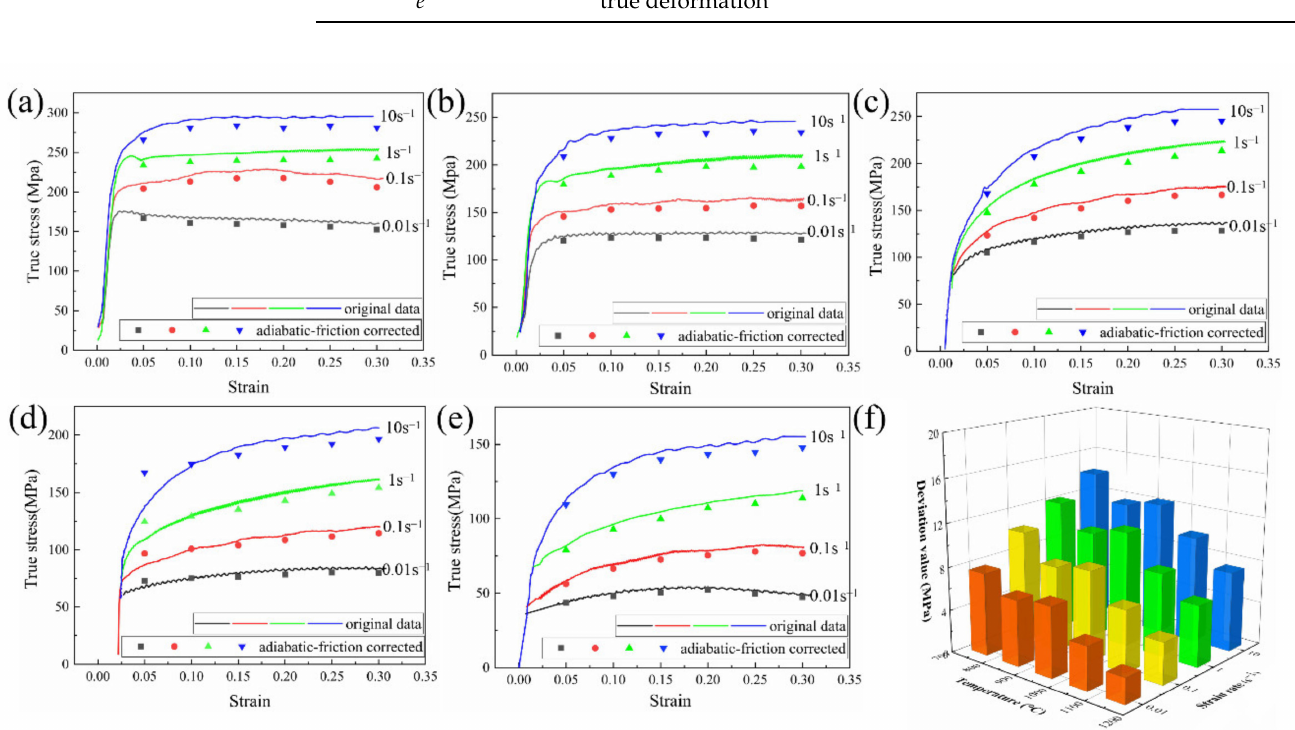
Figure 7. Original stress and adiabatic-friction-corrected stress (0.3) at different temperatures: ( a ) 750 ◦ C, ( b ) 850 ◦ C, ( c ) 950 ◦ C, ( d ) 1050 ◦ C, ( e ) 1150 ◦ C; ( f ) stress deviation